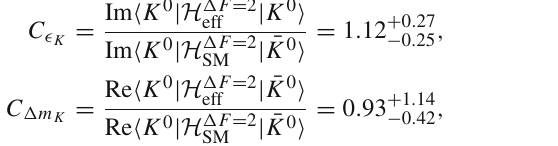
Fig. 3a, the red and yellow coloured boundaries are rep- resenting allowed flavon contribution for current values of C B and φ B , respectively in the minimal model, while s s